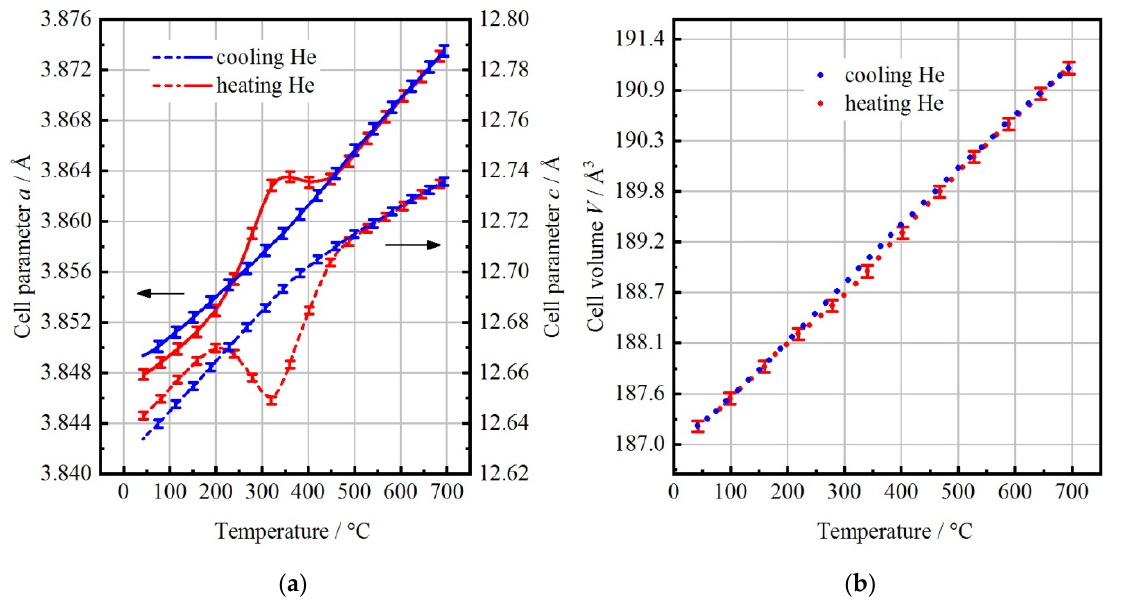
Figure 1. Lattice parameters a, c ( a ) and volume ( b ) as a function of temperature, obtained from XRD patterns for LCNO_01 collected in He flow.